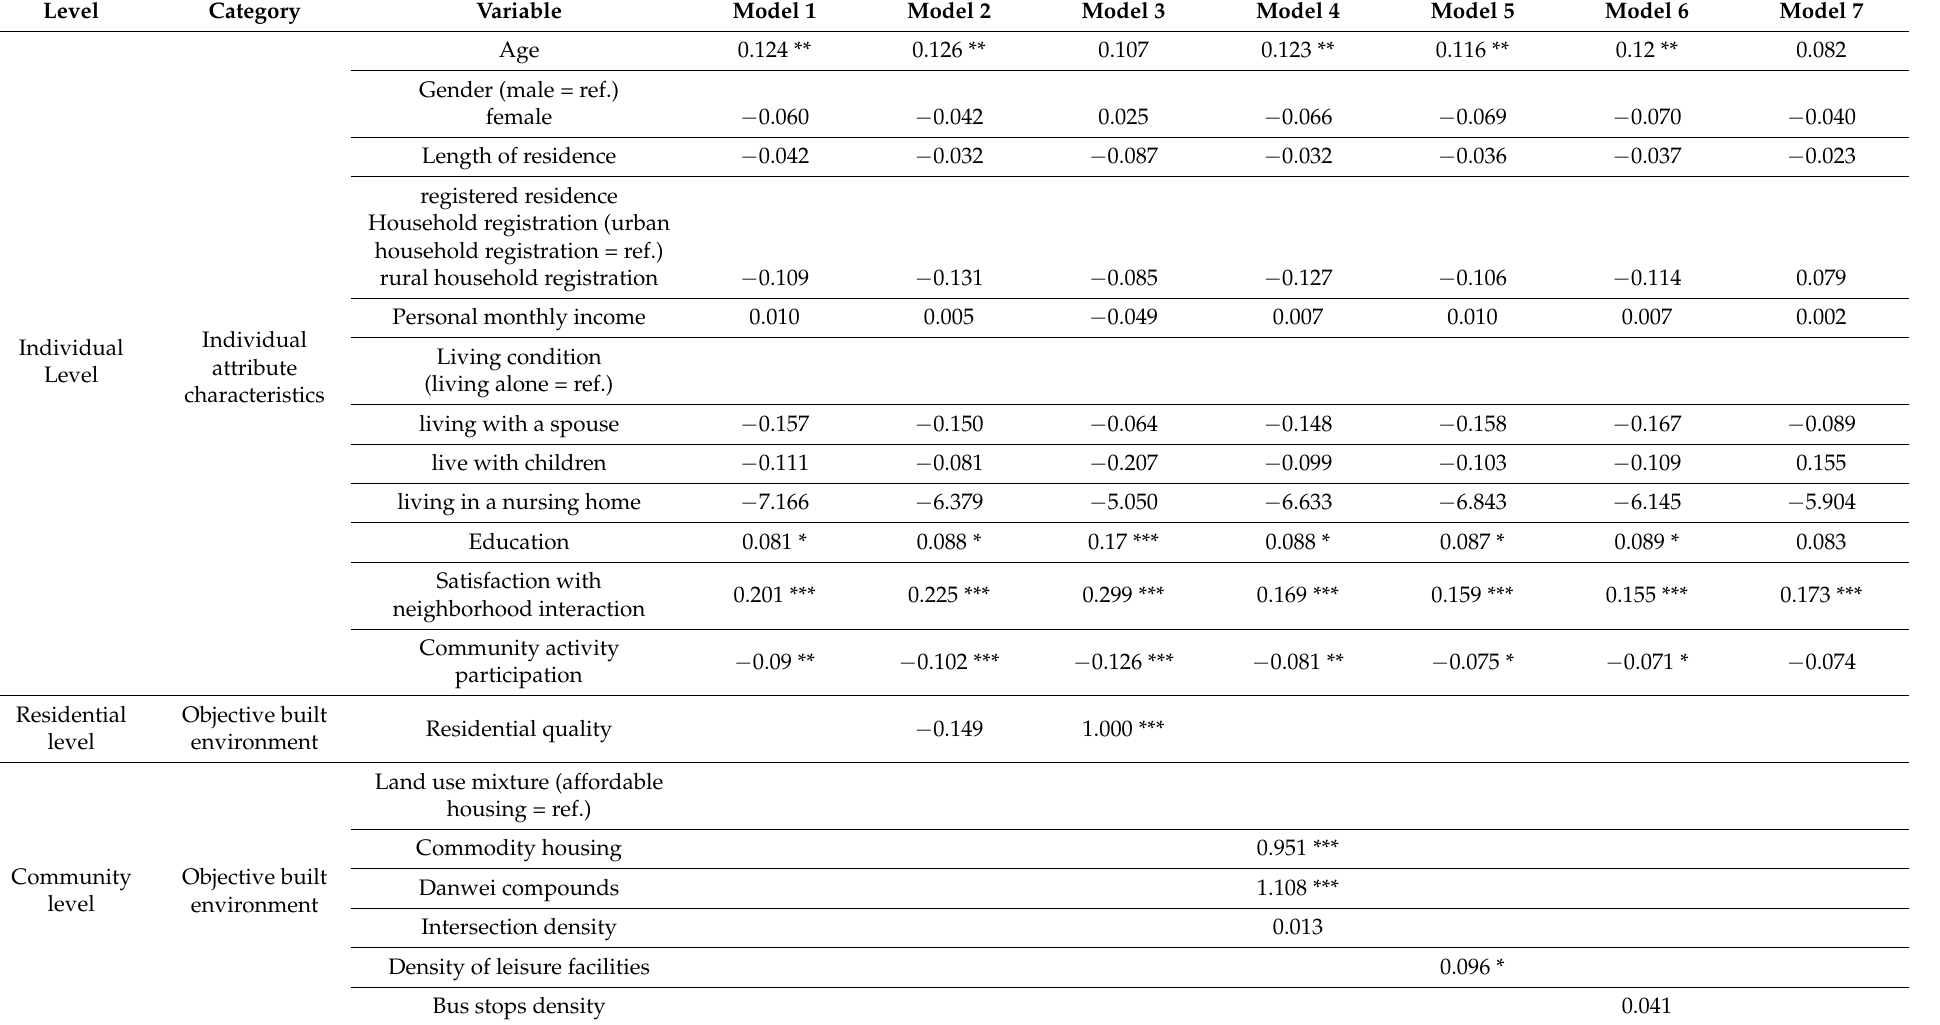
Table 5. The results of multilevel models for the duration of leisure activities of the